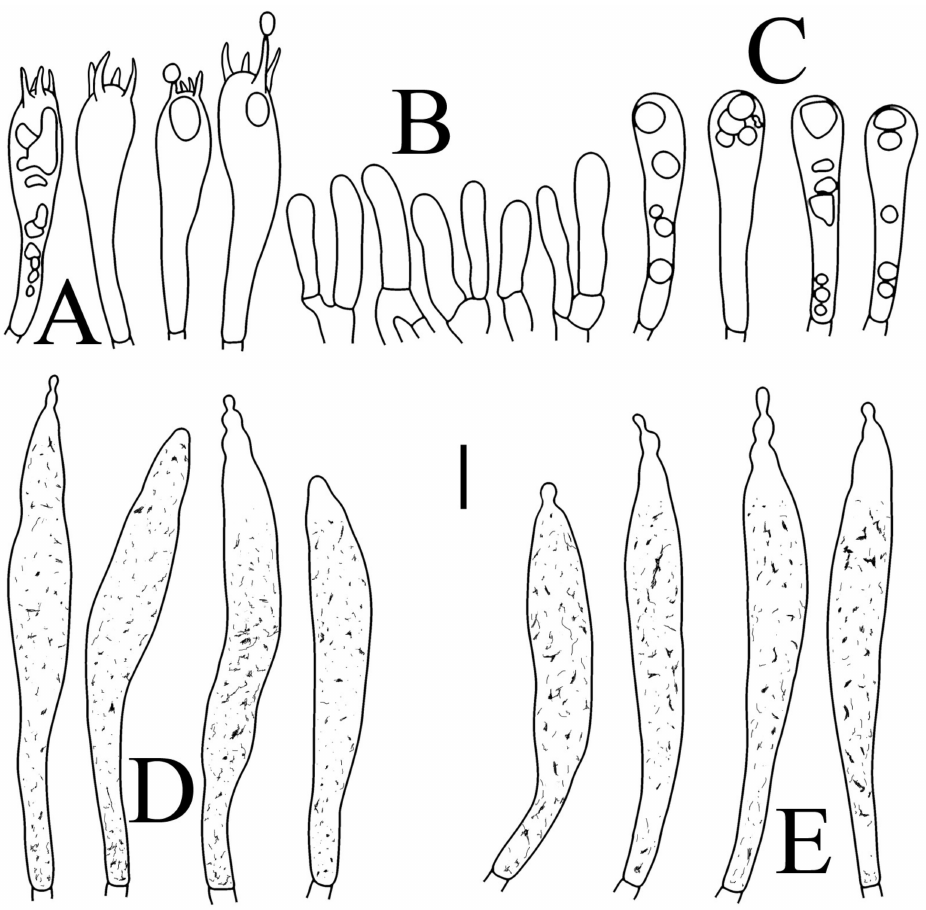
Figure 6. Russula flavescens (RITF5855, holotype): ( A ) basidia; ( B ) marginal cells; ( C )